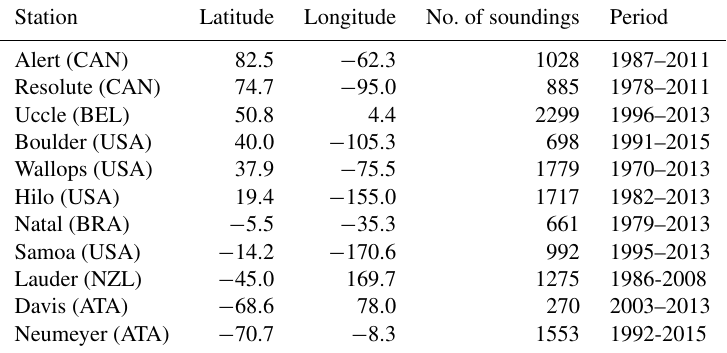
Table 3. Ozonesonde stations used in satellite ozone